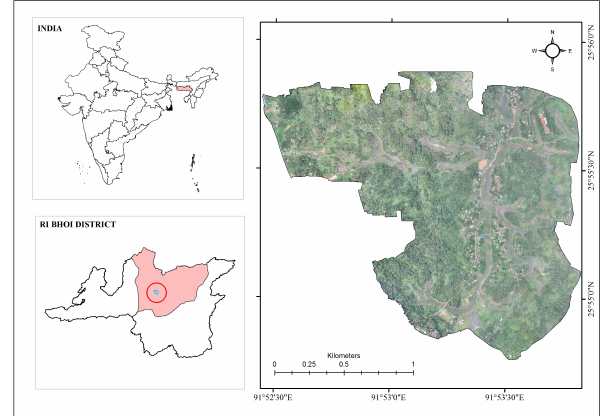
Table 1. Details of bands in the multi-spectral sensor